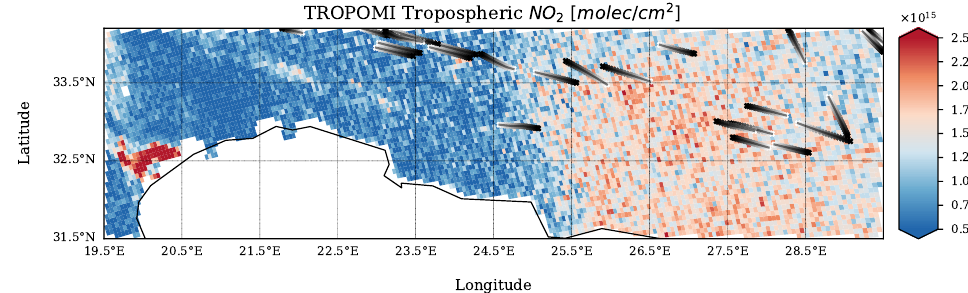
Figure 2. The NO 2 tropospheric column. Visualized day: 14 June 2019. Studied area: the Mediter- ranean Sea, restricted by the northern coasts of Libya and Egypt from the south and the south coast of Crete from the north. Black lines indicate ships’ tracks based on information from AIS data. The red area on the right-hand side of the figure corresponds to the land outflow from the variety of land base sources of NO 2 . For the convenience of visualization, the presented data were not regridded—the native local size of the TROPOMI pixels are presented in the